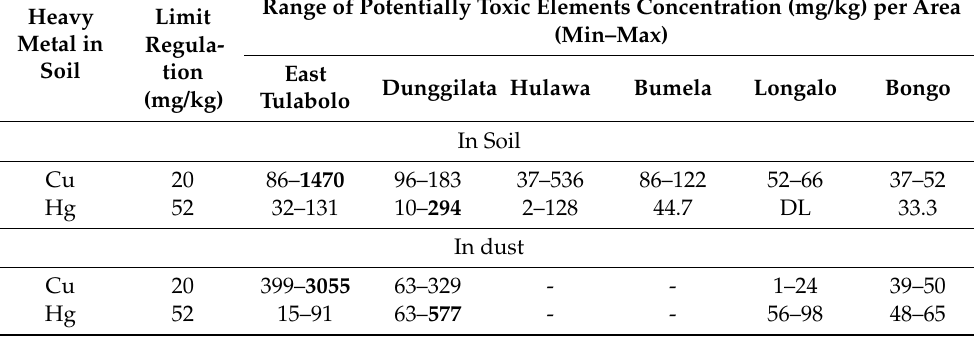
Table 1. Ratio of Cu and Hg concentrations in soil and dust samples per